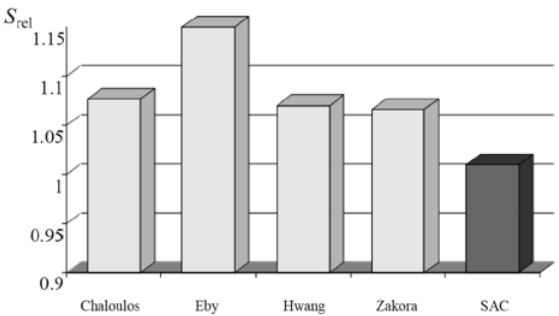
Fig. 2. The value of criterion (3.1) for methods of dual conflict resolution, considered in the references (Chaloulos et al. 2009; Eby 1994; Hwang, Tomlin 2002; Zakora 2006) and for synergistic aircraft control